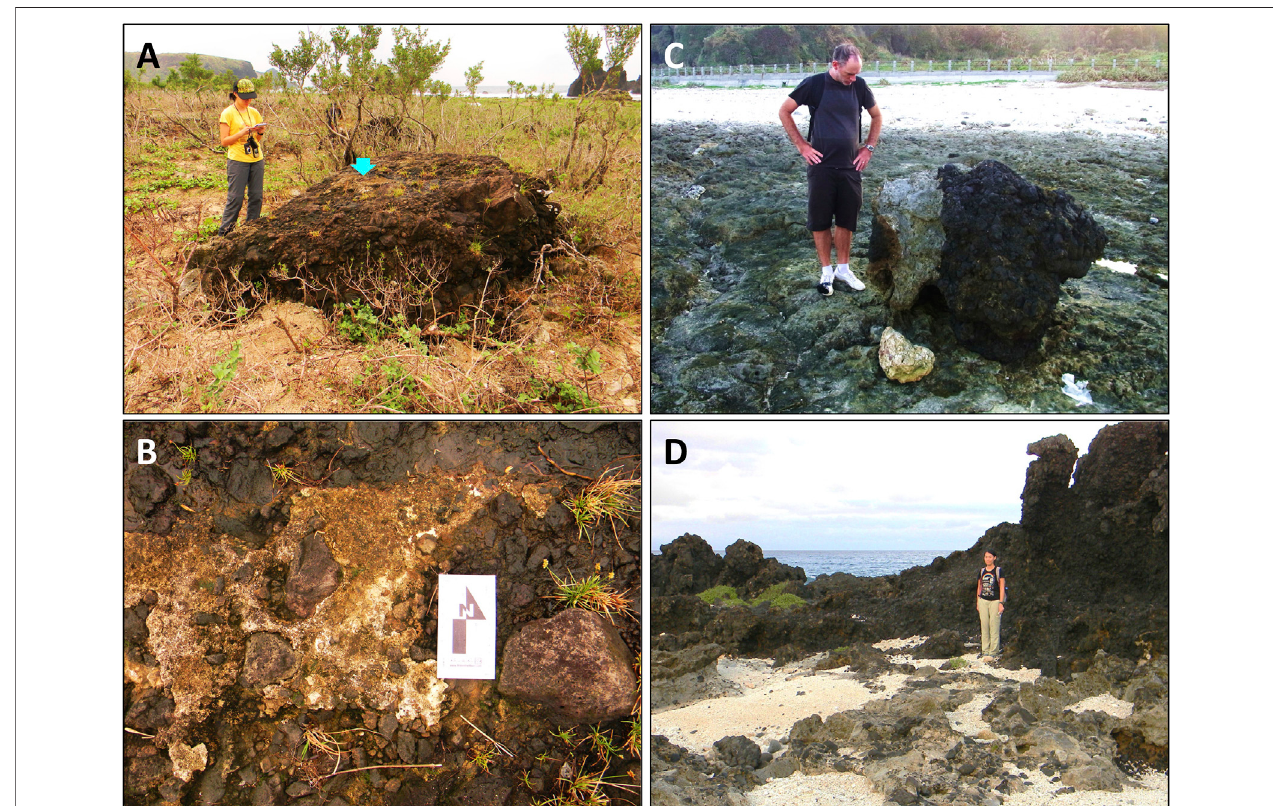
FIGURE 7 | Left: Large volcanic boulder (2.8 × 2.6 × 1.1 m, 12.0 t) with a veneer of limestone cement on its upper surface, as indicated by the blue arrow (A) and seen close up (B) . Right: a volcanic boulder (4.2 t) with an attachment of limestone (C) , showing it was originally attached to the reef but has later been torn off its foundationbypastwaveaction.Thepersonin (D) isstandingatthesourcelocationofthisboulder.BothexamplesareevidencethatsomeofthevolcanicclastsonDahu Reef have been transported (overturned) by past HEW events.